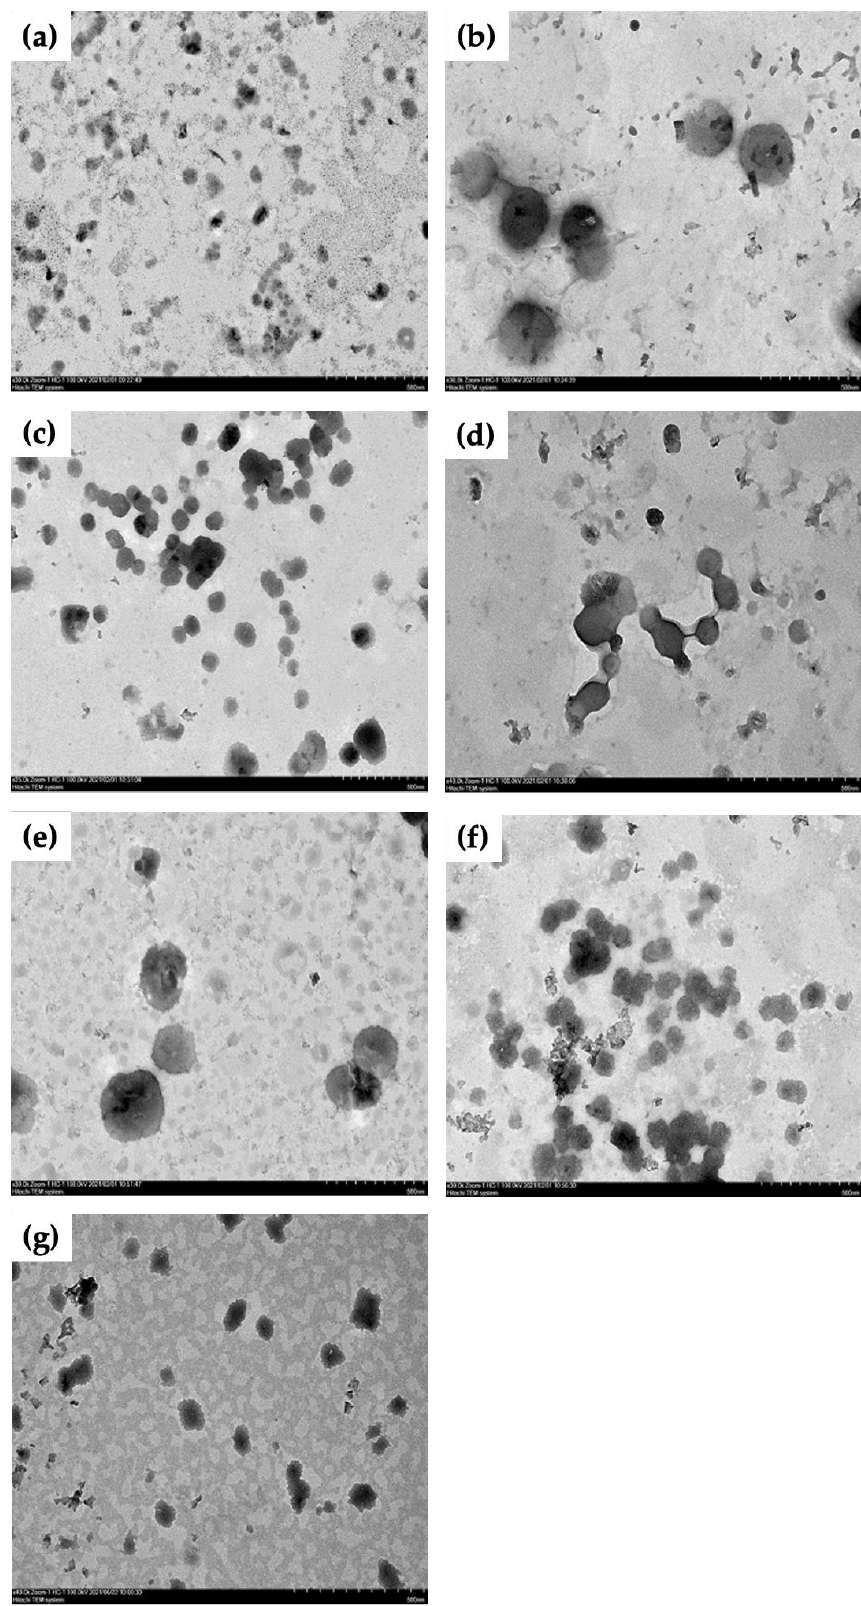
Figure 6. TEM images of liposomal morin with different ratios of morin:lecithin:tween-80, ( a ) (F1) 1:20:20, ( b ) (F2) 1:40:20, ( c ) (F3) 1:80:20, ( d ) (F4) 1:1:20, ( e ) (F5) 1:5:20, ( f ) (F6) 1:10:20, ( g ) (F7) 1:2.5:2.5. Images of samples are magnified by ×30.0 k. Scale bar is 500 nm.